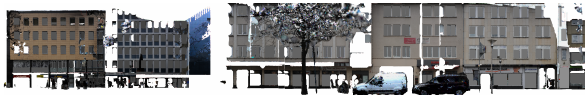
Figure 13: Resulting parallax scrolling